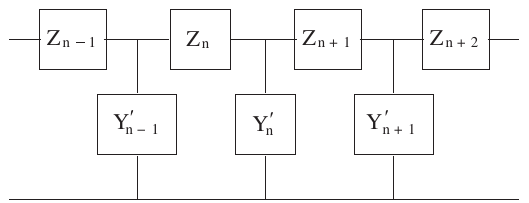
FIG. 1. Equivalent lumped circuit representation of a single DTL cell.